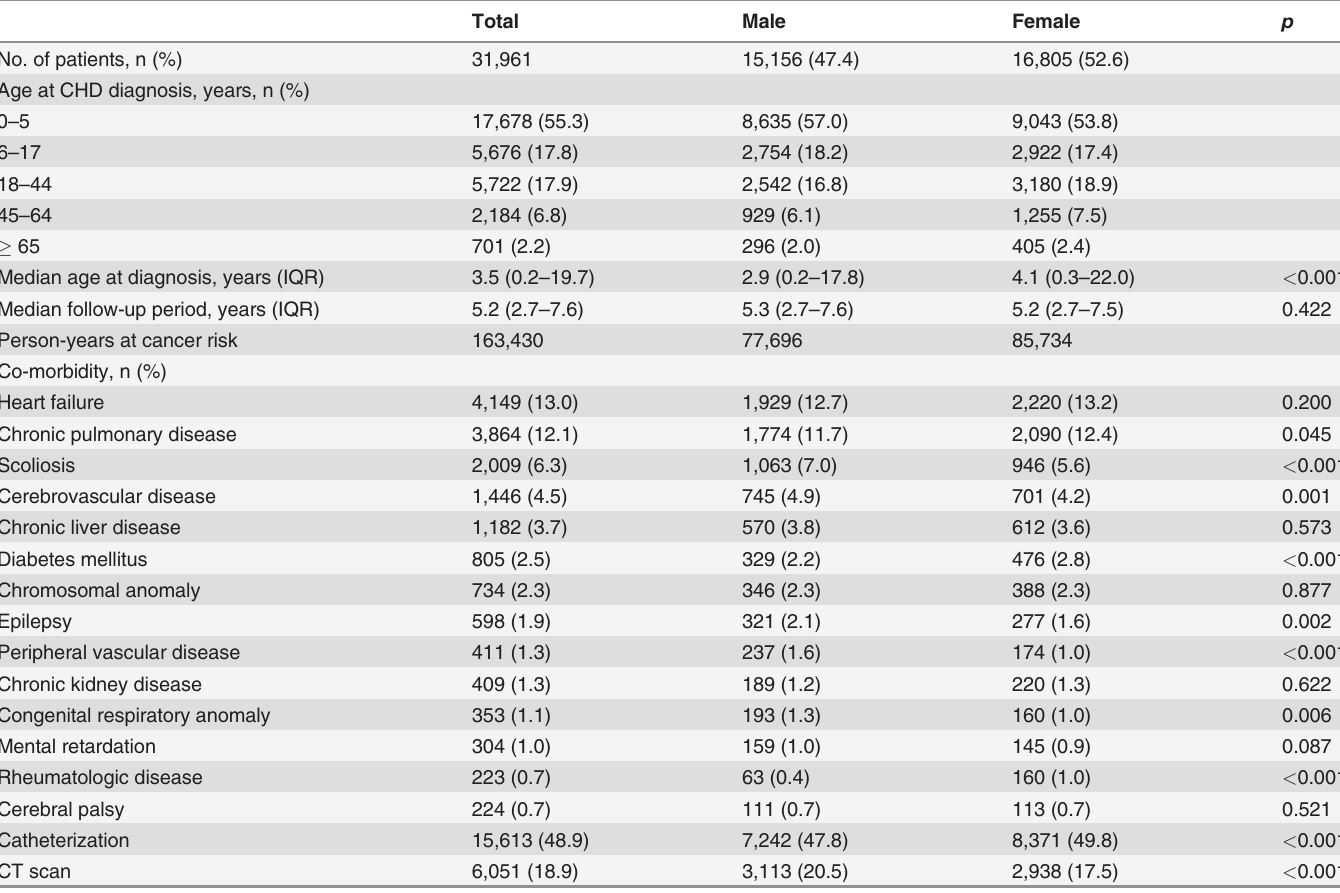
Table 1. Demographic and clinical characteristics of patients with CHD but without any previous history of